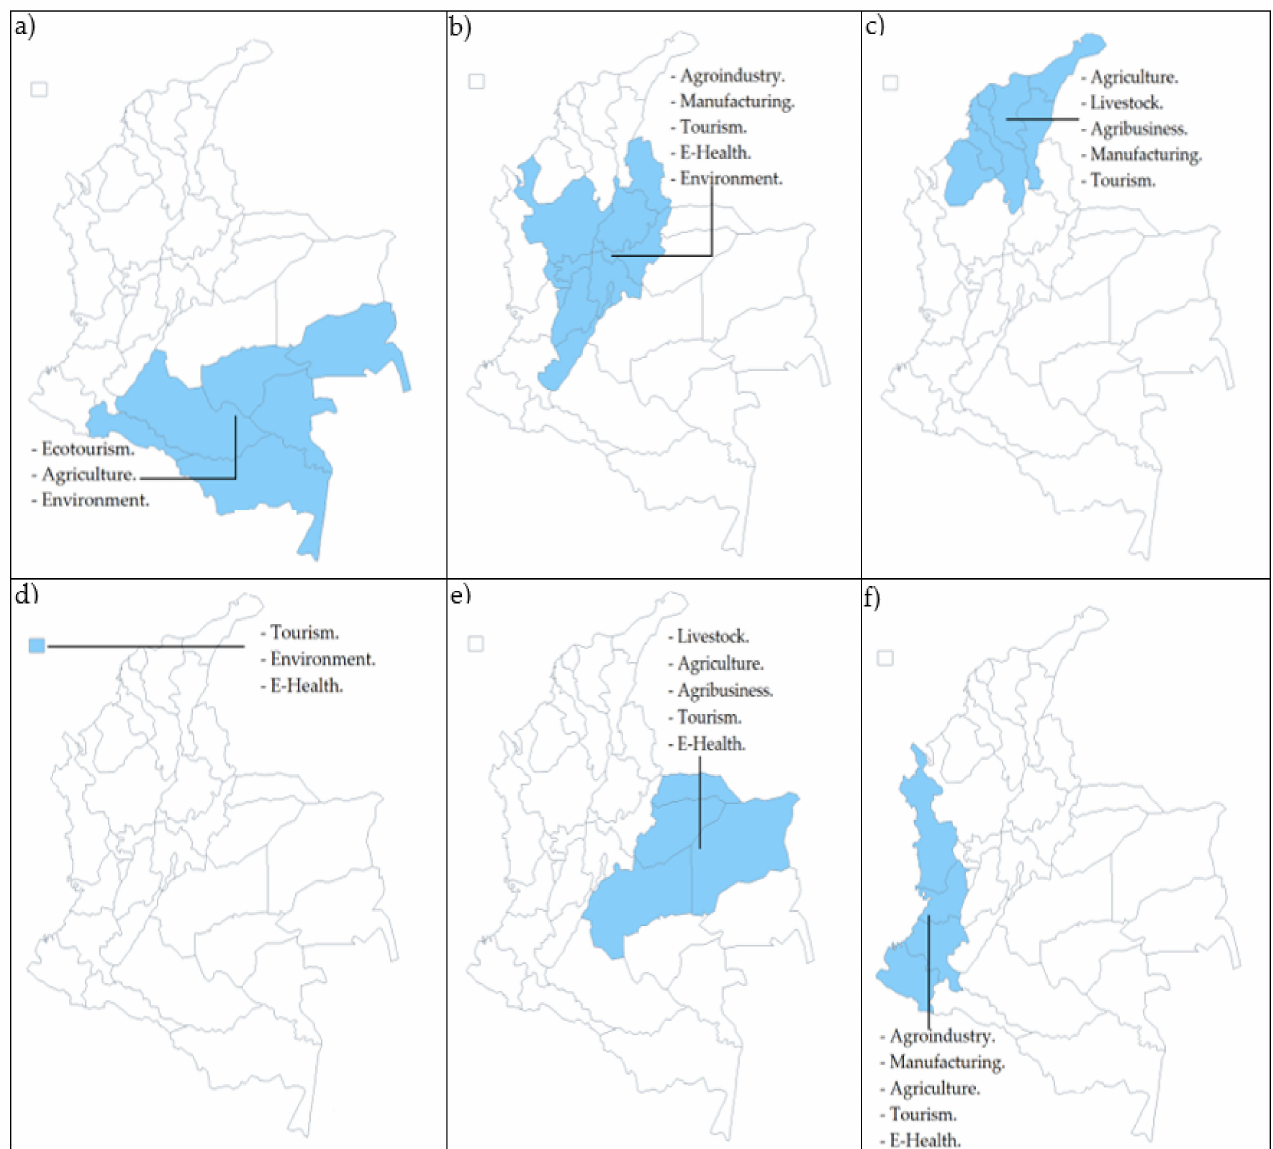
Figure 3. Potential demand for IoT with 5G in natural regions of Colombia according to DDPs: ( a ) Amazon, ( b ) Andean, ( c ) Caribbean, ( d ) Island, ( e ) Orinoco, and ( f )